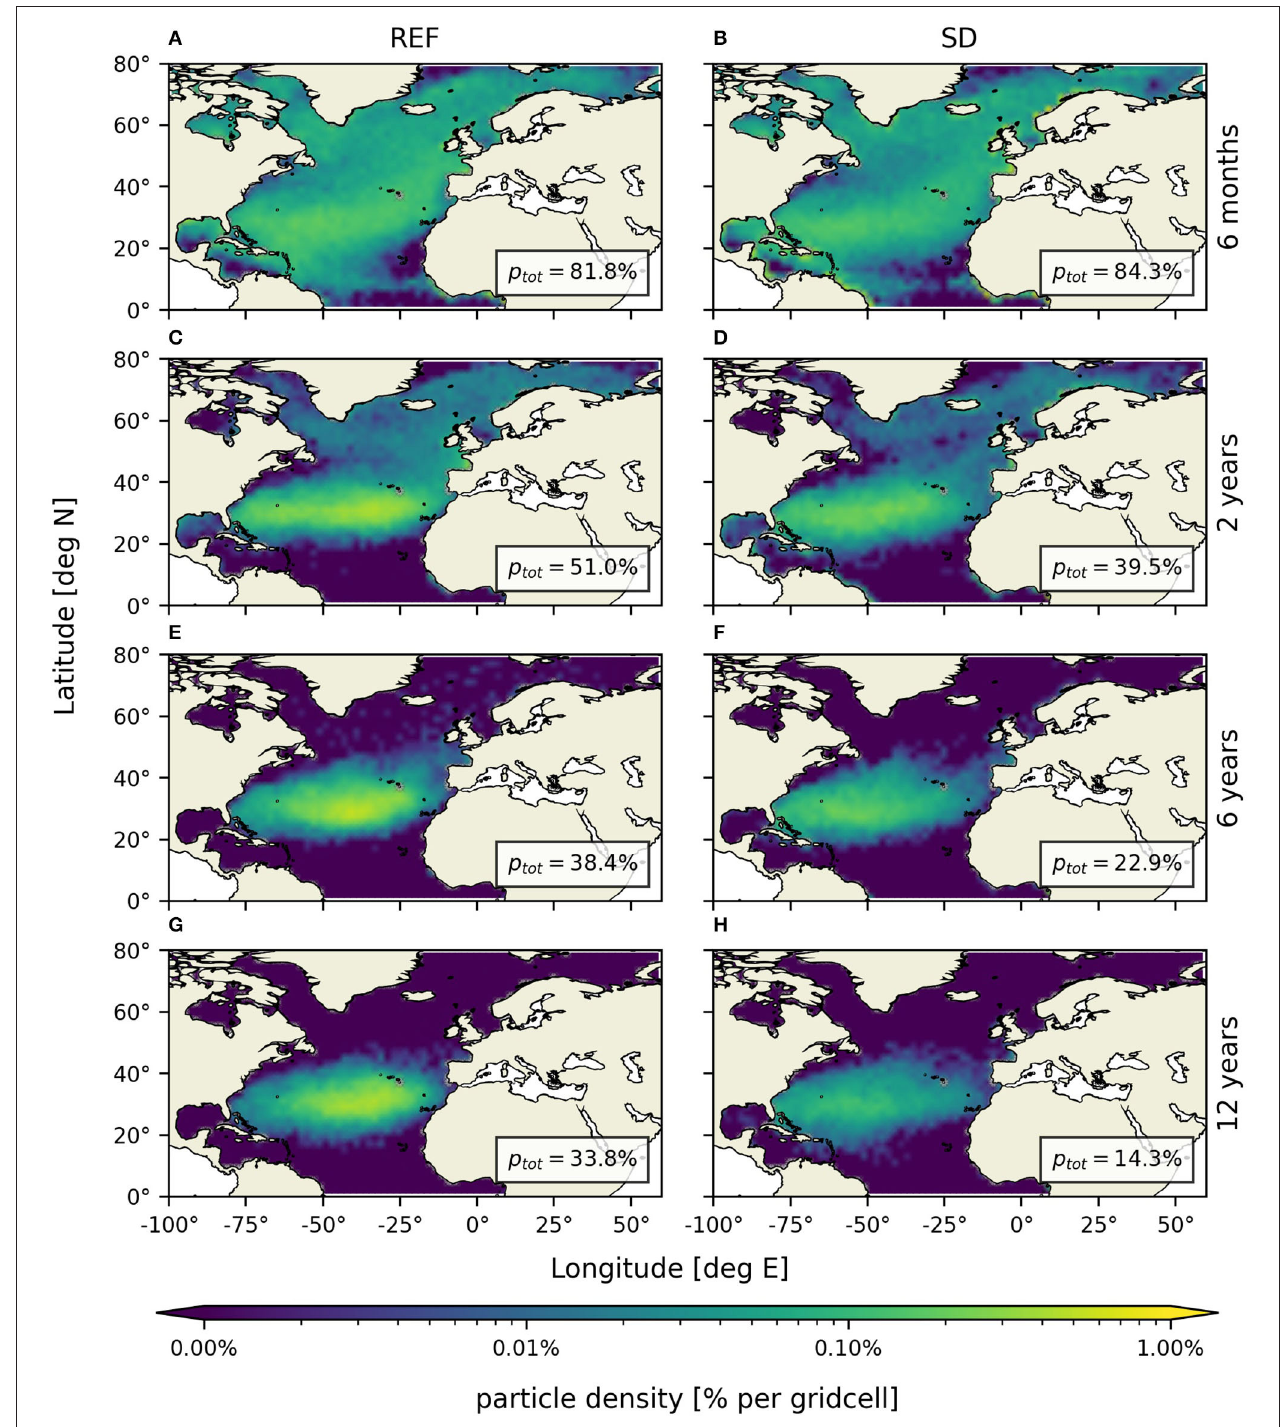
FIGURE 3 | Snapshots of model outputs after 6 months (A,B) , 2 years (C,D) , 6 years (E,F) , and 12 years (G,H) . Colours represent the amount of particles per 2 ◦ bin in percentage, relative to the number of seeded particles. Note the logarithmic scale in the colourbar. Beached particles are detected as in section 2.2 and removed. The text box indicates the amount of remaining particles, p tot